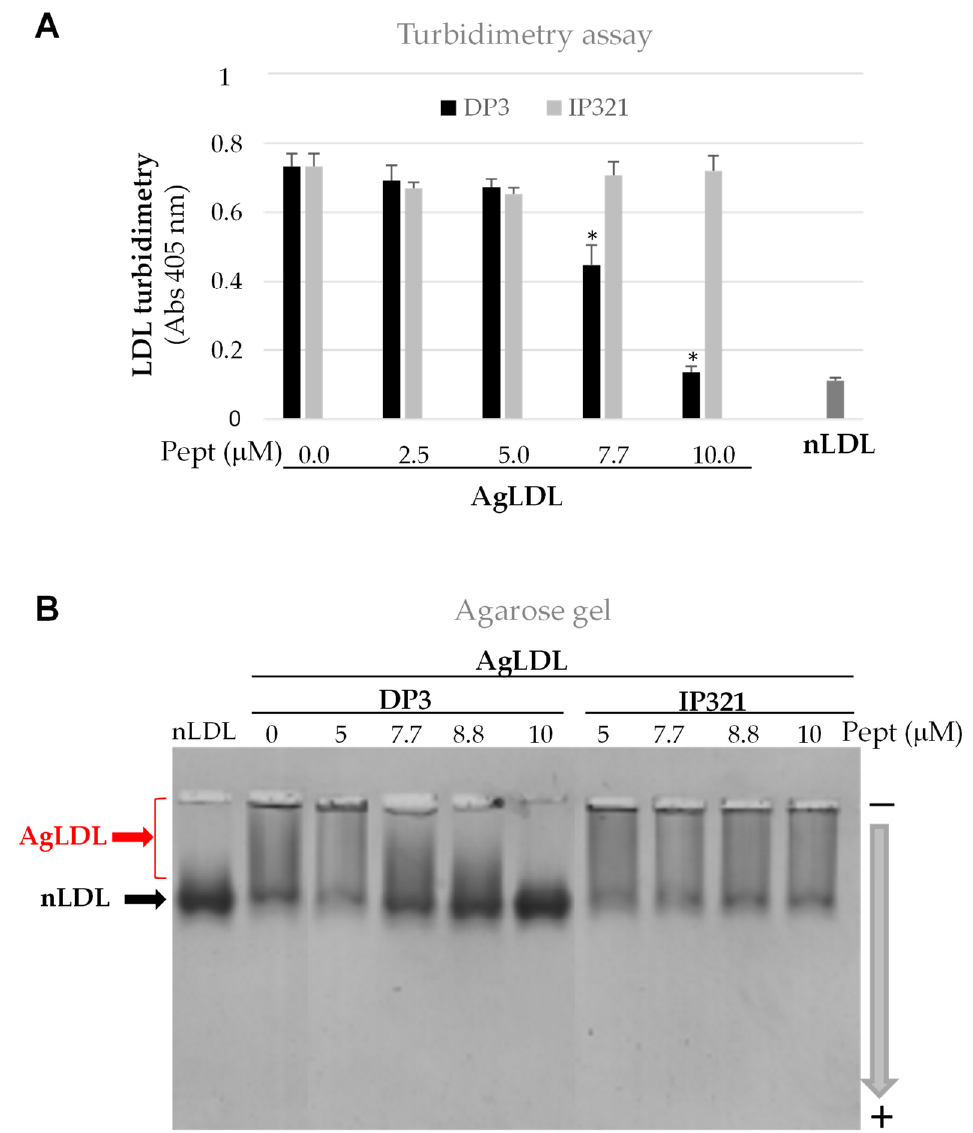
Figure 4. Effects of peptides DP3 and IP321 on SMase-induced LDL aggregation. LDLs were used at 1.44 mg/mL ApoB. The peptides DP3 and IP321 were tested at increasing concentrations (0, 2.5, 5, 7.7, 8.8 and 10 µ M). The effects of peptides on LDL aggregation were monitored by measuring turbidimetry ( A ) and agarose gel electrophoretic mobility ( B ). Results are shown as mean ± SD of three independent experiments (n = 5 biological replicates). * p < 0.001, DP3 vs. IP321. Statistical significance was determined by Student’s t -test. LDL, low-density lipoprotein; nLDL, native LDLs; AgLDL, aggregated LDLs; pept: peptide. Detailed information can be found in Table S1 and Figure S7.